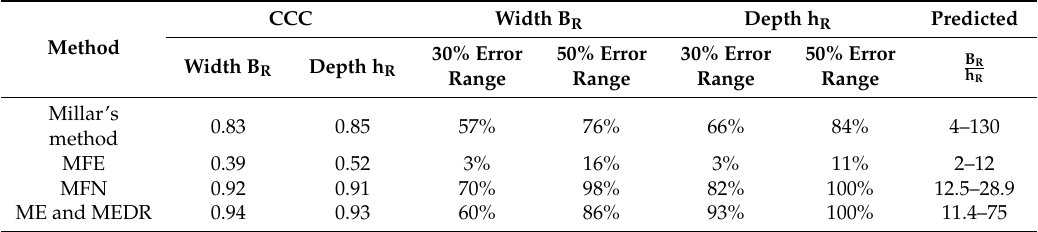
Table 3. Statistics computed for Millar’s method, MFE, MFN, and ‘ME and MEDR’ based on sparse gravel data.